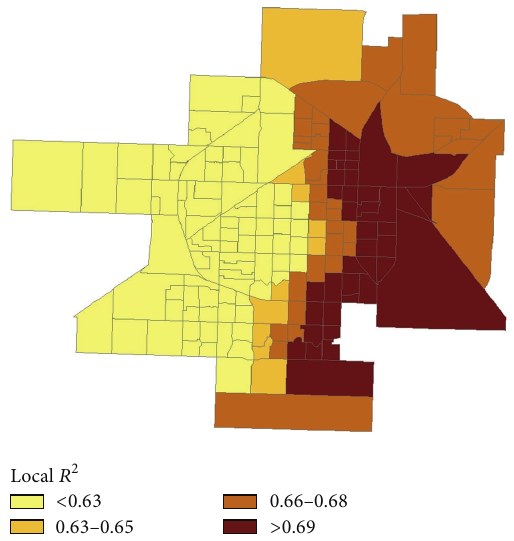
Figure 2: Distribution of local R -squared values, Lubbock, Texas,